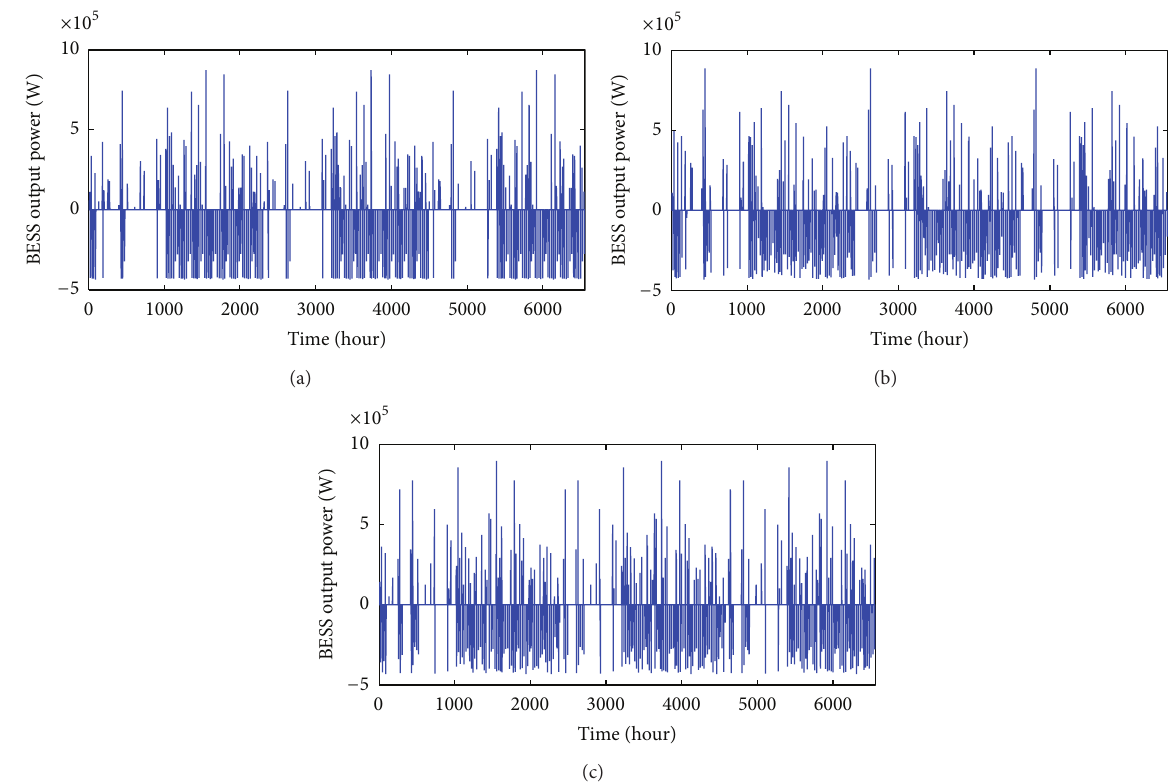
Figure 8: Hourly BESS output power for optimal BESS size obtained with (a) EOFA, (b) FA, and (c) GSA.